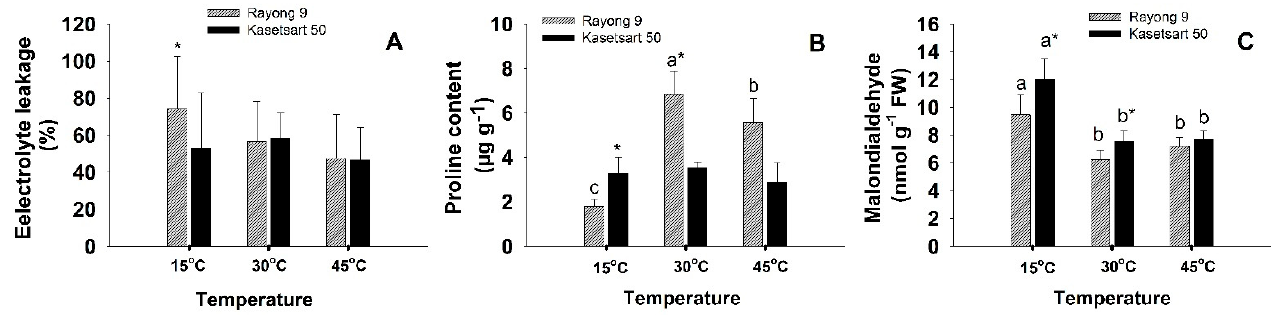
Figure 3. The effects of short-term exposure to different temperatures (15, 30 and 45 °C) on electro- lyte leakage (EL) ( A ), proline ( B ), and malondialdehyde (MDA) ( C ) of cassava cvs. Rayong 9 and Kasetsart 50. Means (±SD) which are significantly different ( p < 0.05) among treatment for each pa- rameter are denoted by different lower-case letters. The significant differences between cassava gen- otypes are denoted with *.